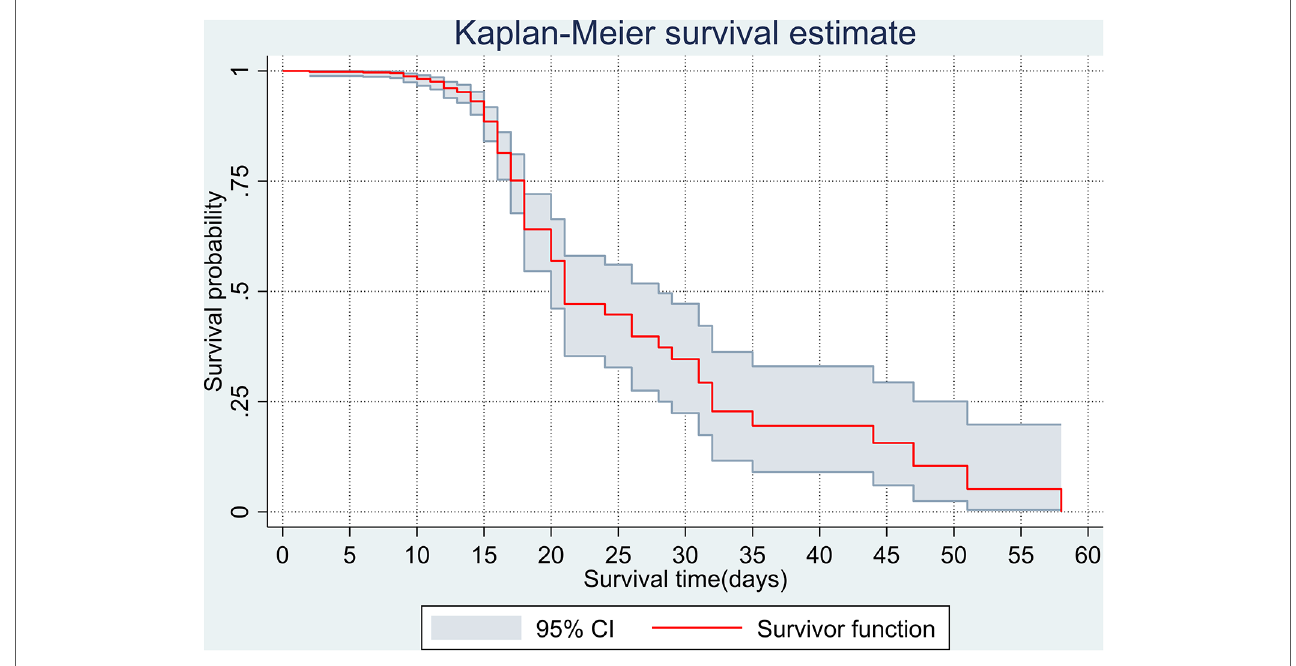
FIGURE 1 Overall Kaplan – Meier survival estimate of adult COVID-19 patients in Ethiopia,